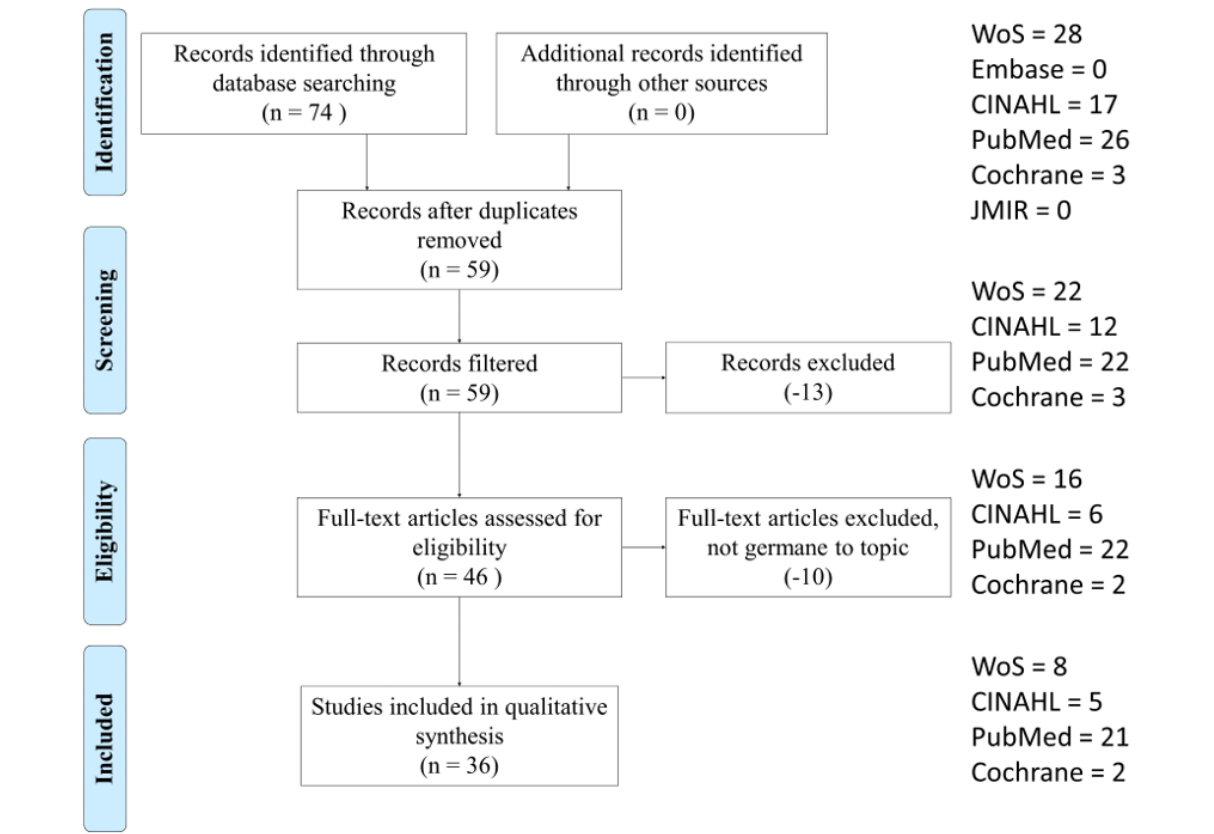
Figure 1. Article selection process with selection